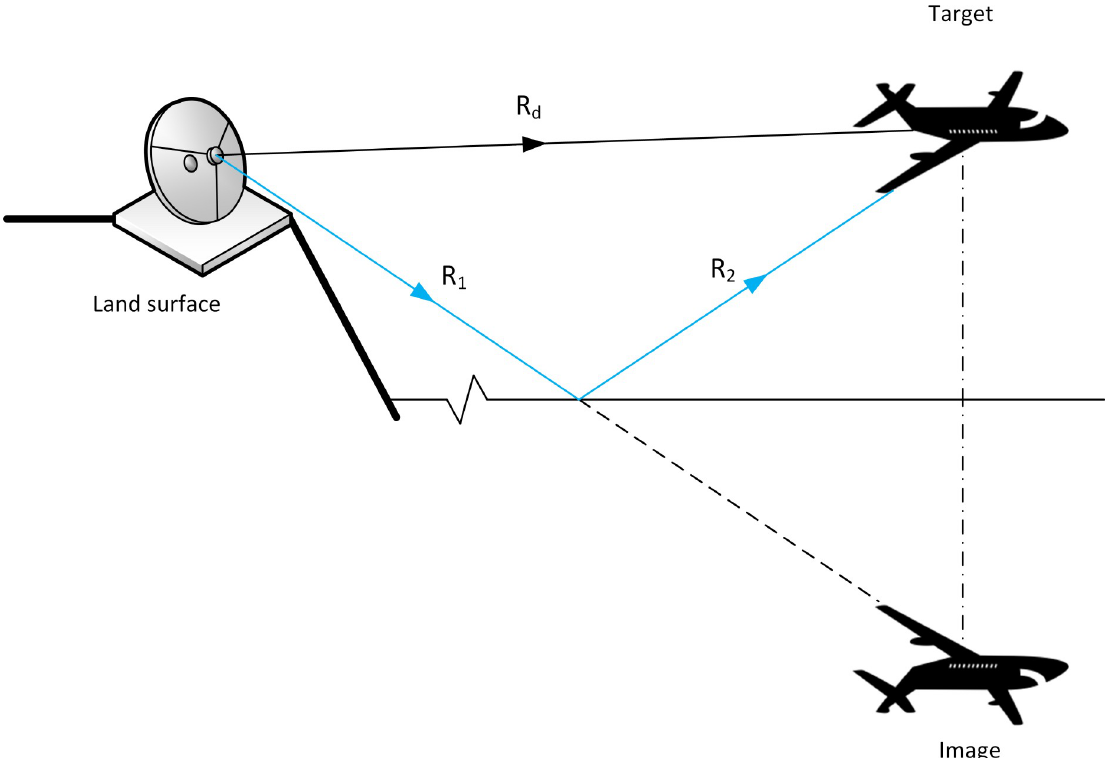
Fig 6. Multipath issue based on the two-ray ground-reflection theory.